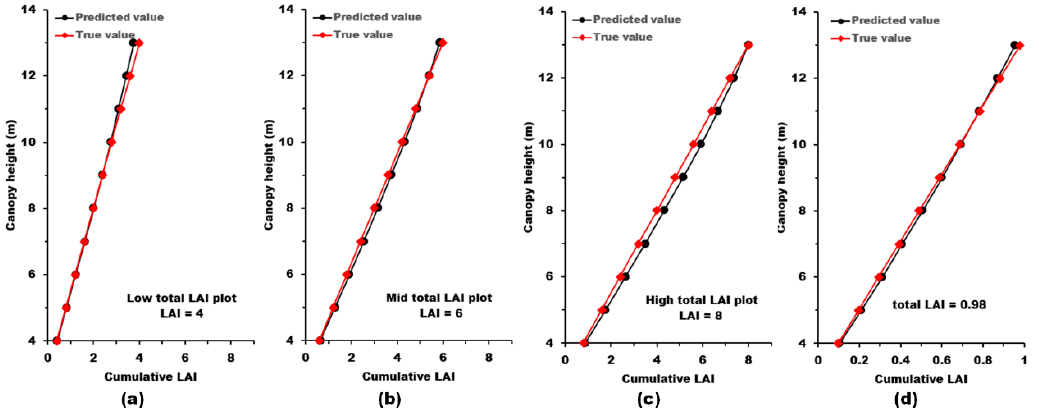
Figure 5. Comparisons between true reference cumulative LAI and predicted cumulative LAI derived from the DART model simulated waveform data.